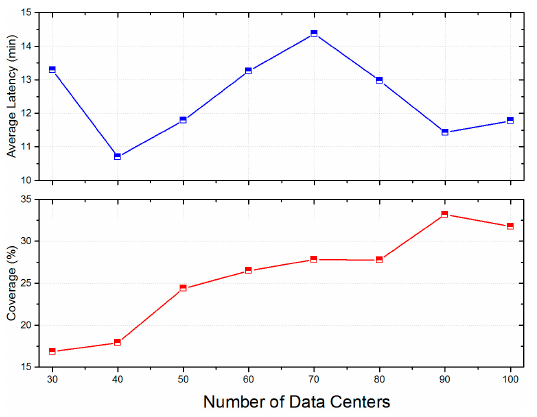
Figure 14. Average latency and coverage with different number of data centers.